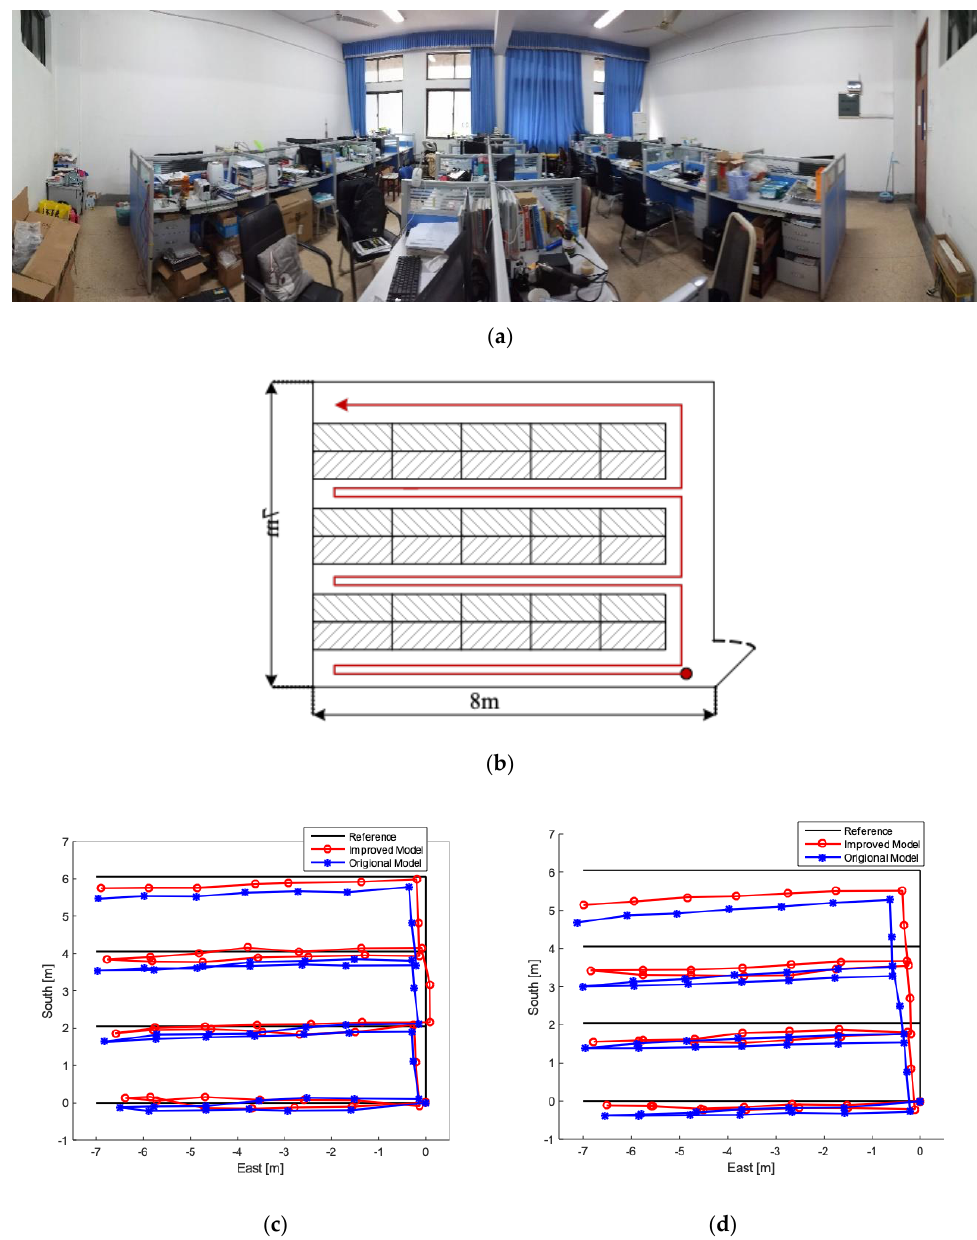
Figure 15. Typical experiment 1. ( a ) Laboratory under panoramic view; ( b ) experimental diagram. ( c ) experimental results of Mti series MEMS-IMU from Xsens. ( d ) Experimental results of AH-100B.